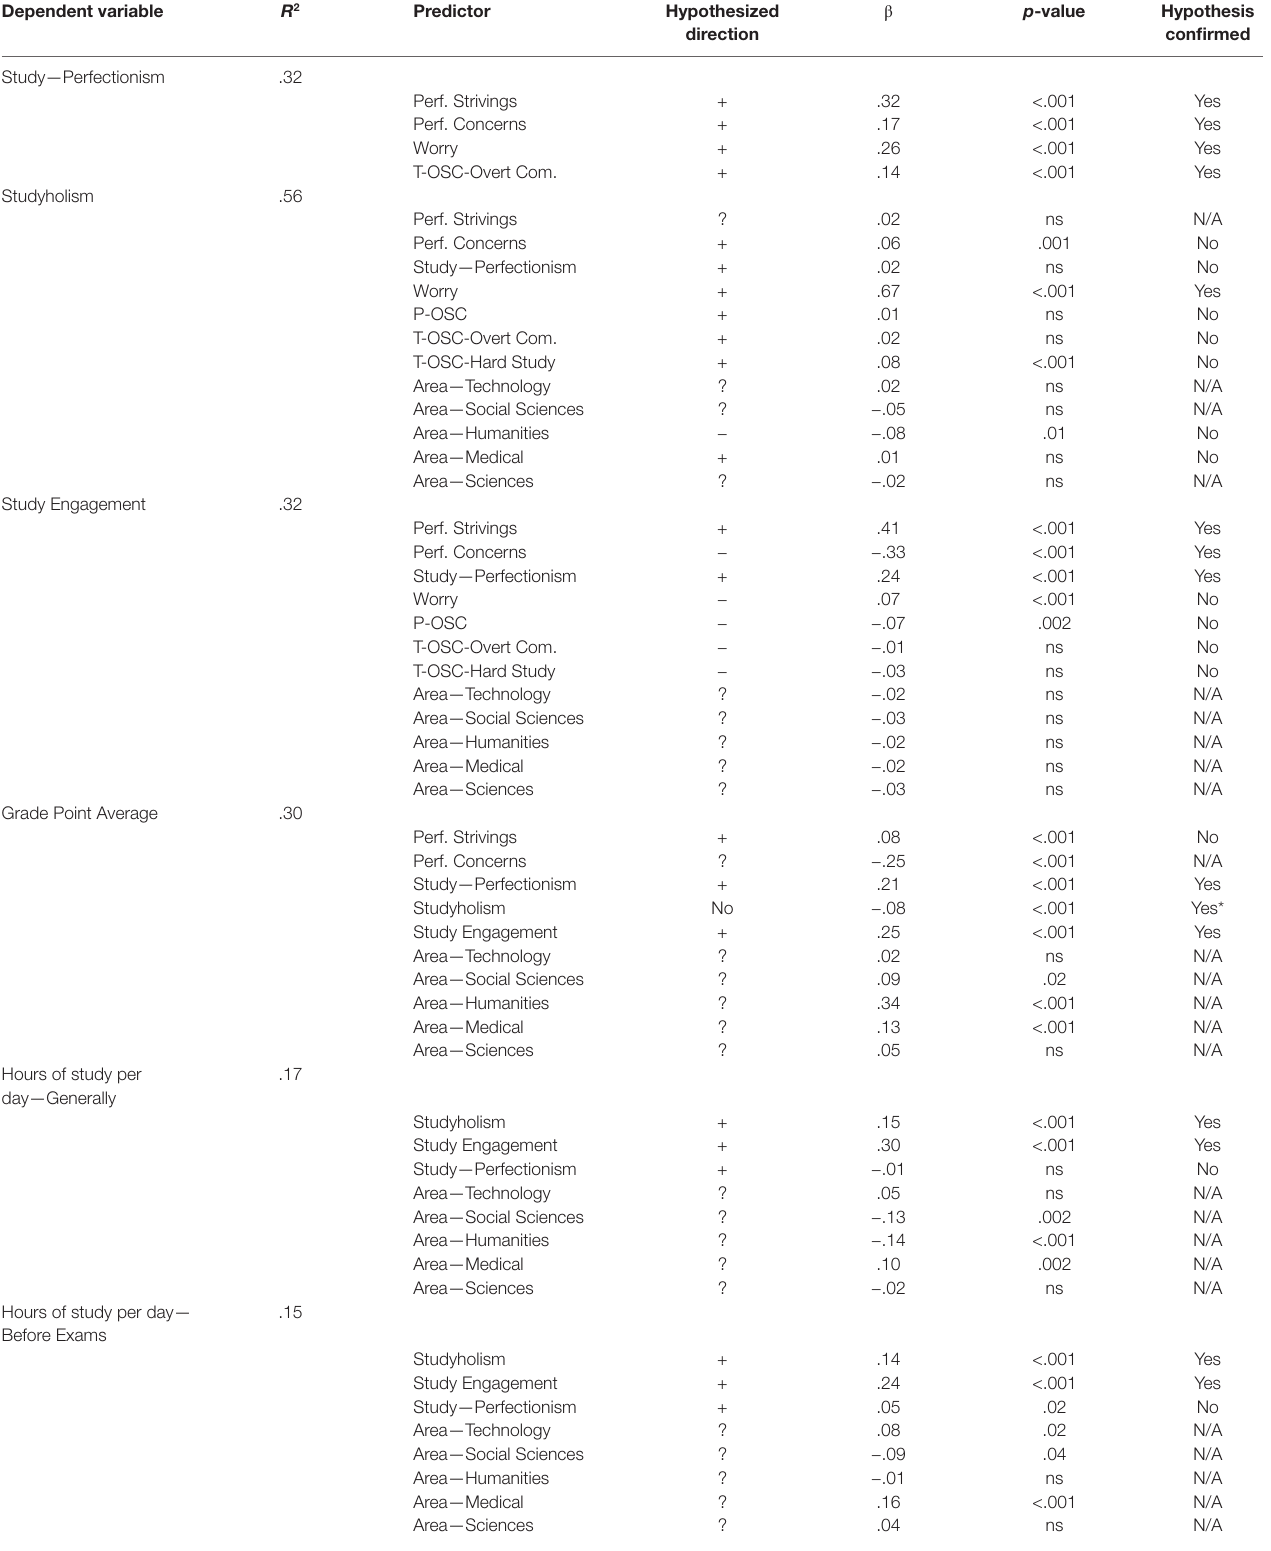
TABLE 5 | Hypothesized model for studyholism and study engagement antecedents and outcomes (see Hypothesized Direction column) and standardized path weights and R 2 for each dependent variable of the structural equation model ( n = 1,958). Dependent variable R